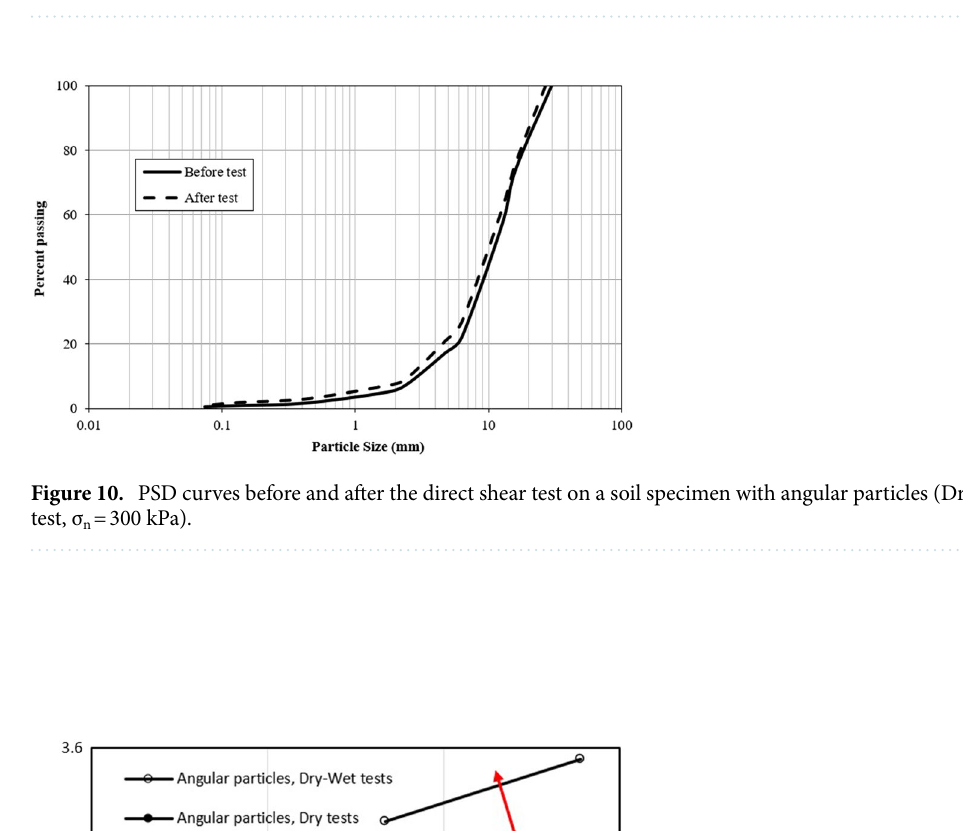
Figure 9. Definition of particle breakage index 38 .